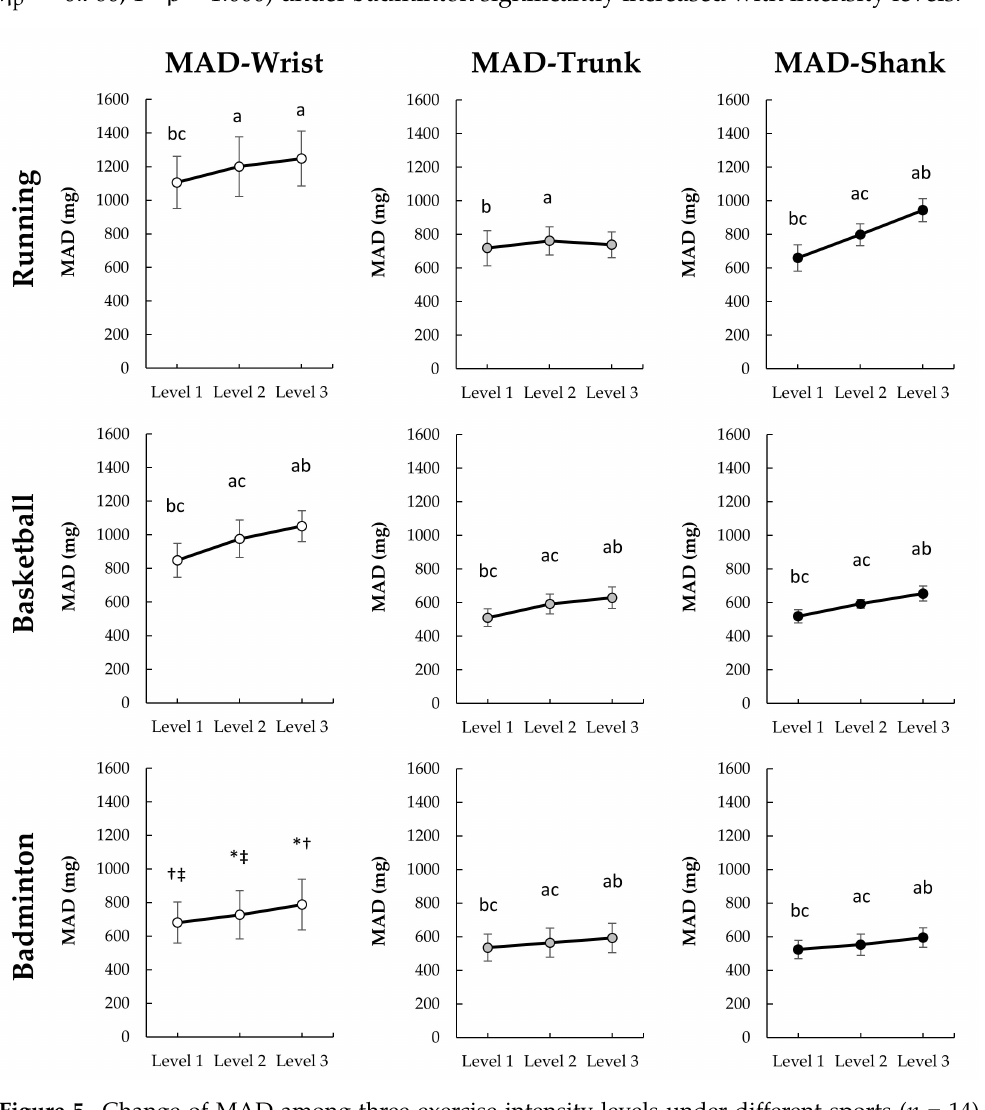
Figure 5. Change of MAD among three exercise intensity levels under different sports ( n =